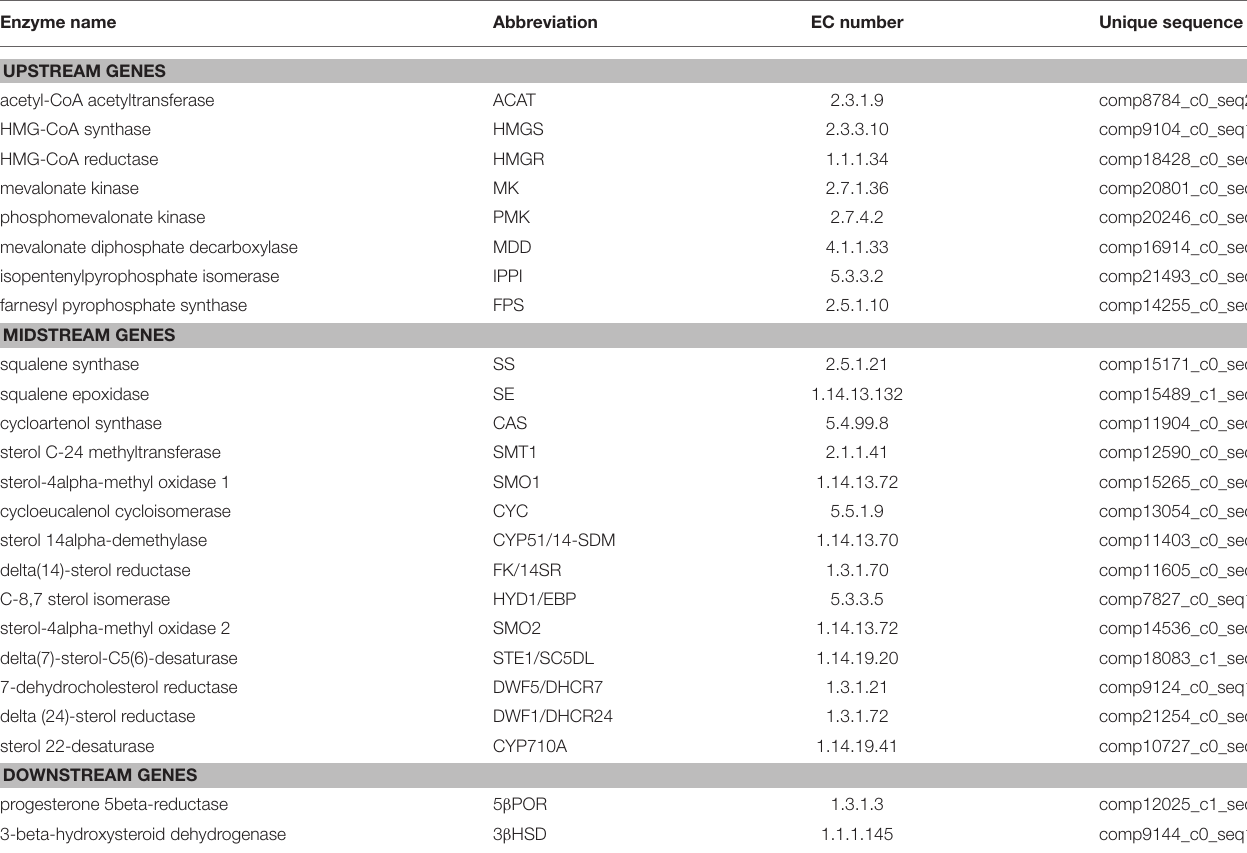
TABLE 4 | Discovery of genes involved in the steroid biosynthesis pathway in Periploca sepium